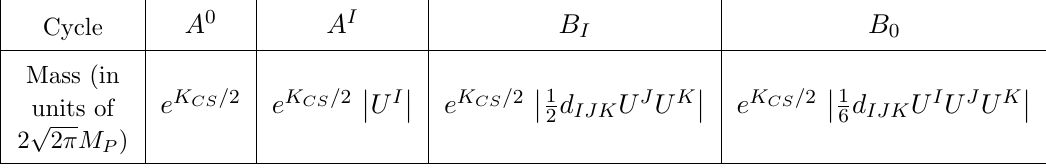
Table 6. DBI masses of particles formed by D3-branes wrapping 3-cycles. I runs from 1 to h 1 ; 2 . These masses depend only on the complex structure moduli through (cid:10) and the K(cid:127)ahler po- (cid:0) 4 (cid:1) tential given by K = (cid:0) log d u I u J u K , in the limit of large complex structure. CS IJK 3